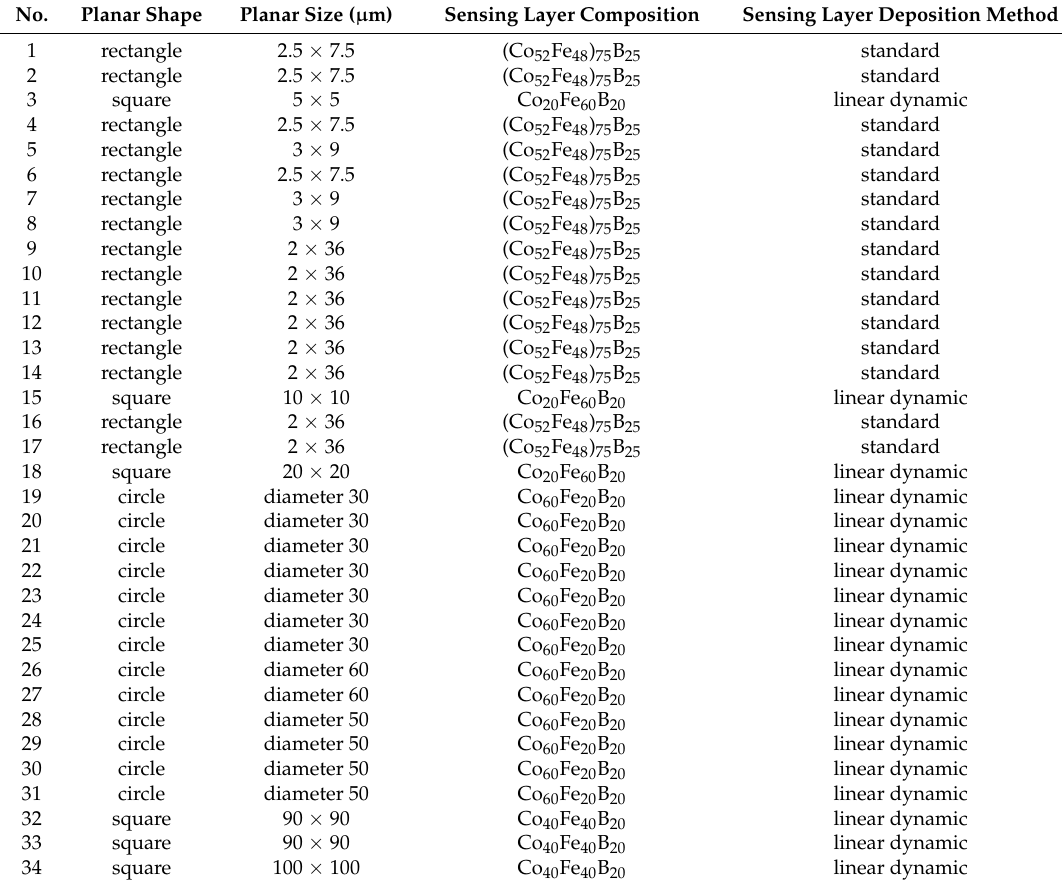
Table A2. Selected physical and technological characteristics of the TMR sensors used for calibration. In the sensing layer deposition method column, “standard” refers to DC standard magnetron sputtering and “linear dynamic” refers to linear dynamic DC magnetron sputtering